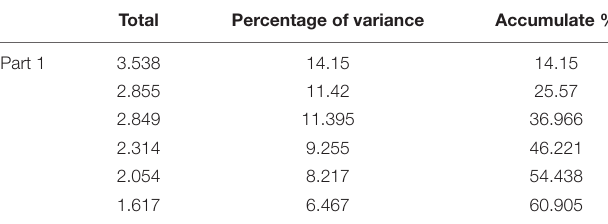
TABLE 8 | Variance interpretation of scale samples.